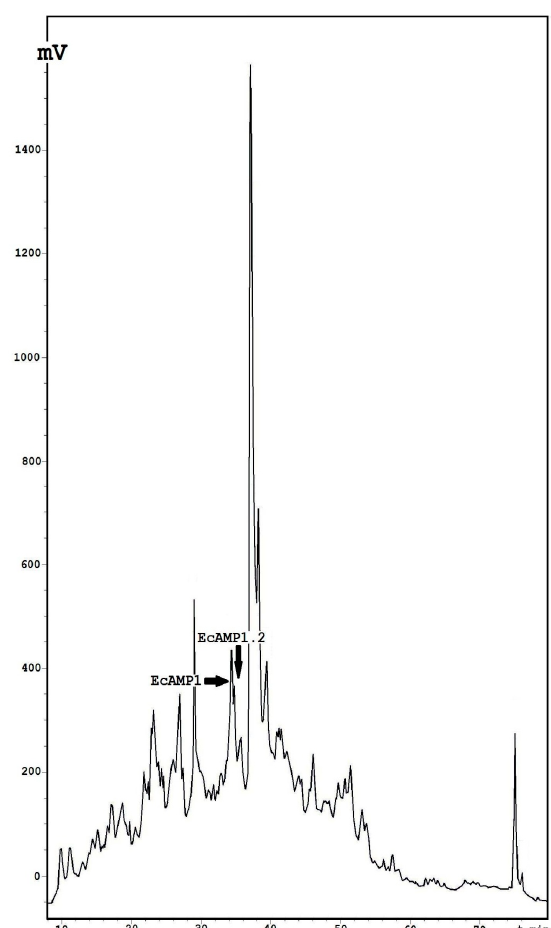
Figure 1. Isolation of the EcAMP1 peptides by analytical reversed-phase high performance liquid chromatography (RP-HPLC). Peaks corresponding to the EcAMP1 and EcAMP1-Hyp are indicated by the black arrows.